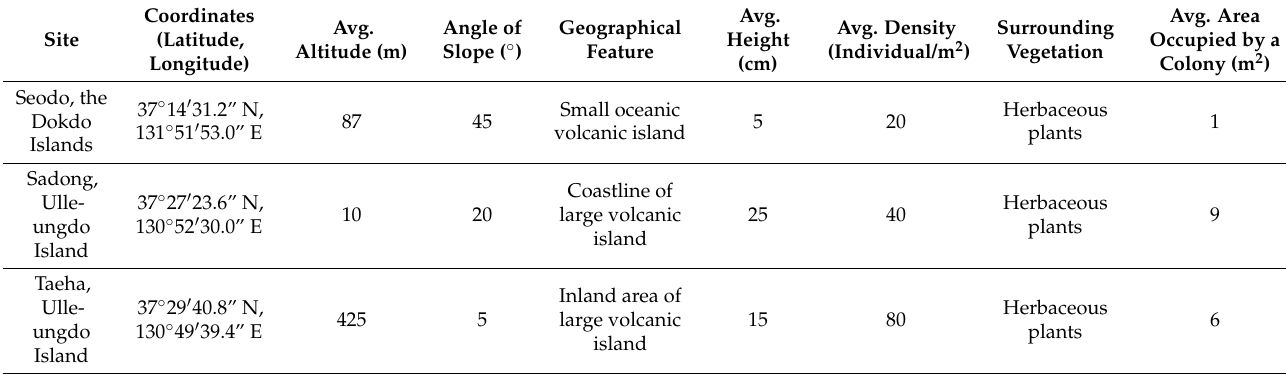
Figure 1. Geographically segregated natural habitats of the Korean bellflowers. The map images were downloaded from the Cultural Heritage Administration of Korea (CHA) Portal Site (http://www.heritage.go.kr/heri/idx/index.do, accessed on 21 October 2020) and modified for this study. Table 1. Sampling site